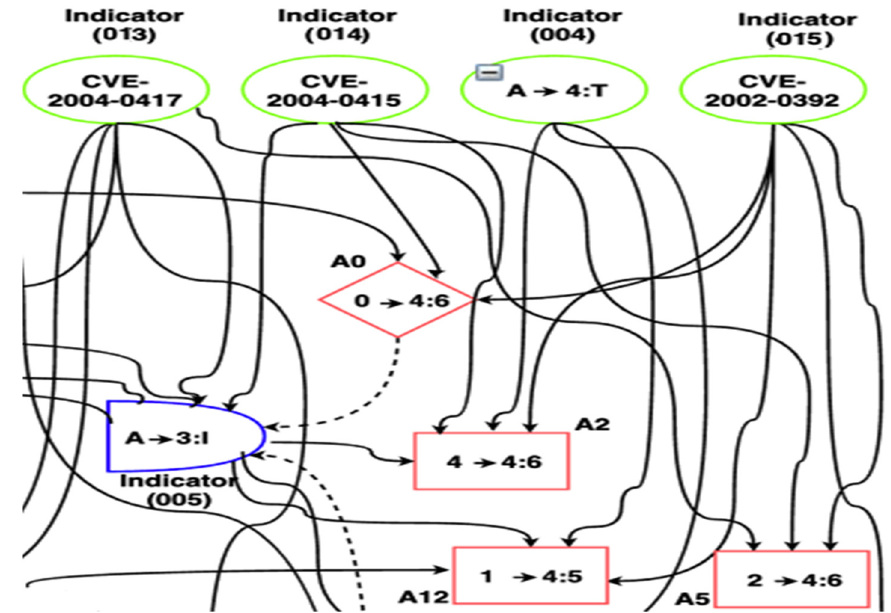
Figure 5. Part of an example of the generated attack